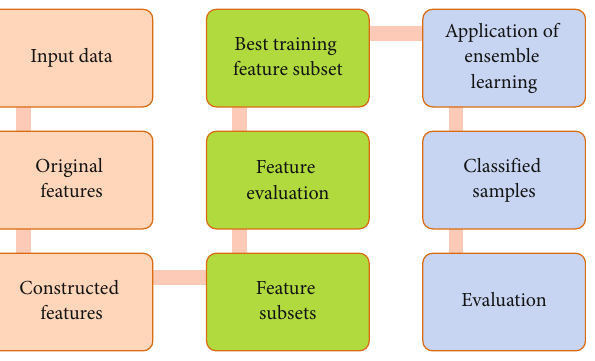
Figure 2: Proposed model.